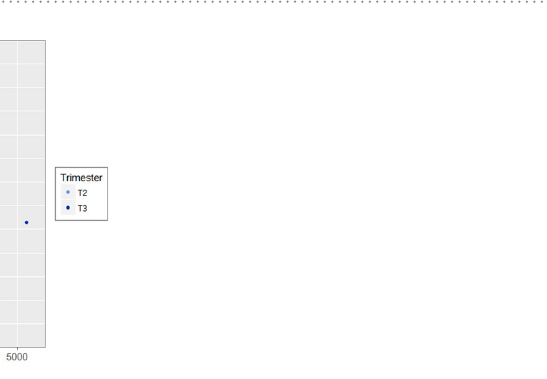
Figure 3. Distribution of deepest vertical pocket (DVP) according to estimated fetal weight (EFW) and stratified by 2nd (18–28 weeks) and 3rd (29–40 weeks) trimester of pregnancy.